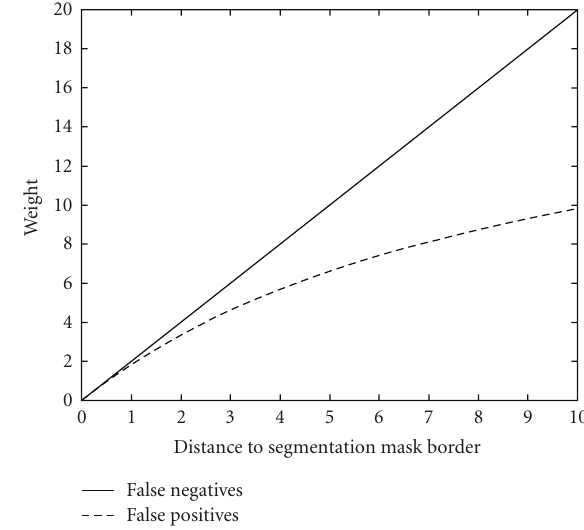
Figure 10: Weighting functions for false positives and false nega-